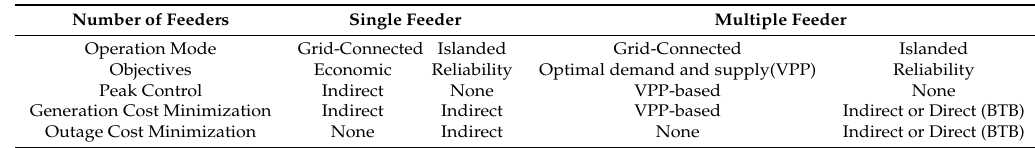
Figure 1. An example of the form of power sharing in a multiple microgrid (MMG) system structure with two feeders. Table 1. Types of power sharing based on various conditions.